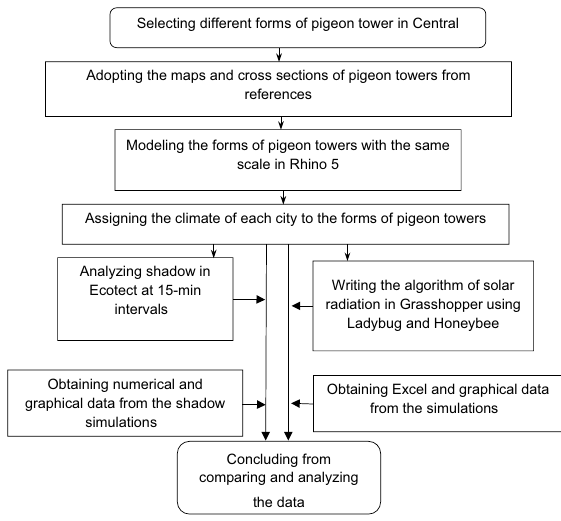
Figure 2. Analytical diagram of solar radiation and shadow on the surfaces of pigeon towers in Central Asia